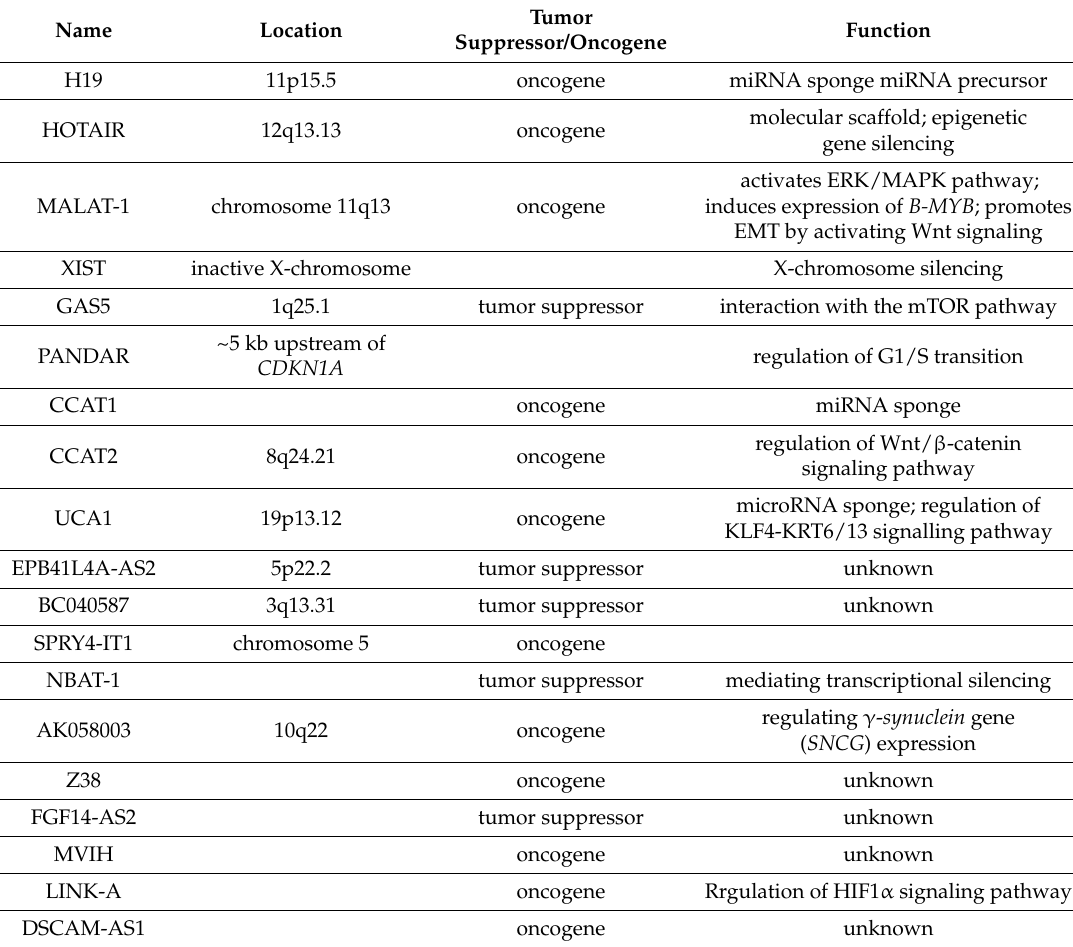
Table 1. Known lncRNAs in breast cancer. This list is demonstrating their location and main